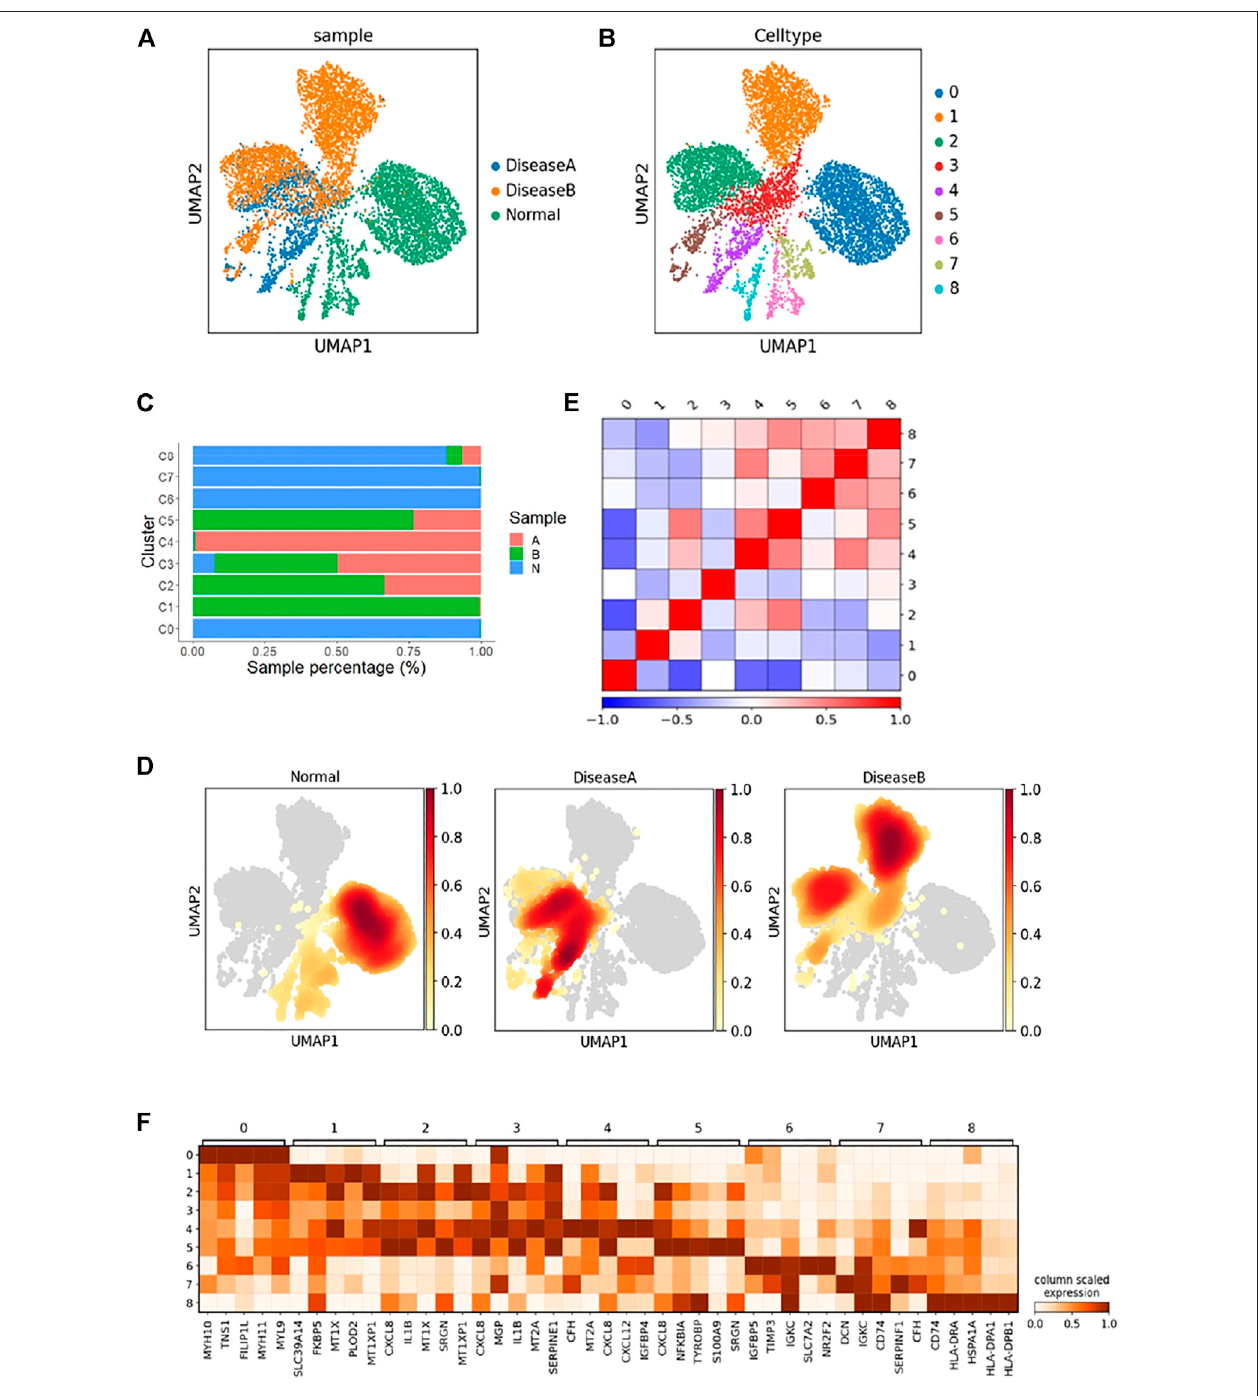
FIGURE 3 | Heterogeneity of smooth muscle cells in human ascending thoracic aortic walls. (A) UMAP plot showing SMCs of different samples by Seurat and Harmonyanalysis. (B) SMCswerefurtherdividedintoninesubclusters(C0~8)showninthecolor-codedUMAPplot. (C) Theproportionofeachclusterofcellsindifferent samples. (D) Nuclear density fi gure showing thedifferentspatial distributionofSMCs,the degree ofred indicates the density ofthe cells. (E) CorrelationanalysisofSMC subclusters. (F) Heatmap showing the top fi ve genes and their relative expression in each subcluster of SMCs. (G) The expression distribution of hypervariable genes in each cell. (H) The violin diagram shows some special changed genes in SMCs of diseases. (I) RNA velocity analysis showed the possible transition between differentcluster cells. Thearrow shows thedirectionofthetransformation. (J) The violindiagramshowingsome special changed genesin subcluster SMCsofdiseases. (K) Differences in pathway activities scored per SMCs by GSVA with different subclusters. (L,M) Differences in pathway activities scored per SMCs by GSVA among disease a and normal (L) , disease b and normal (M) . A: disease a, B: disease b, N: normal.